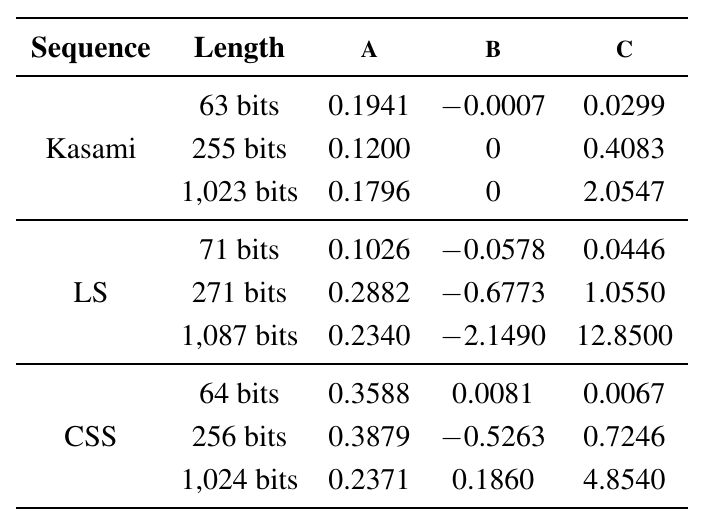
Table 3. Polynomial coefficients of the quadratic fit for all